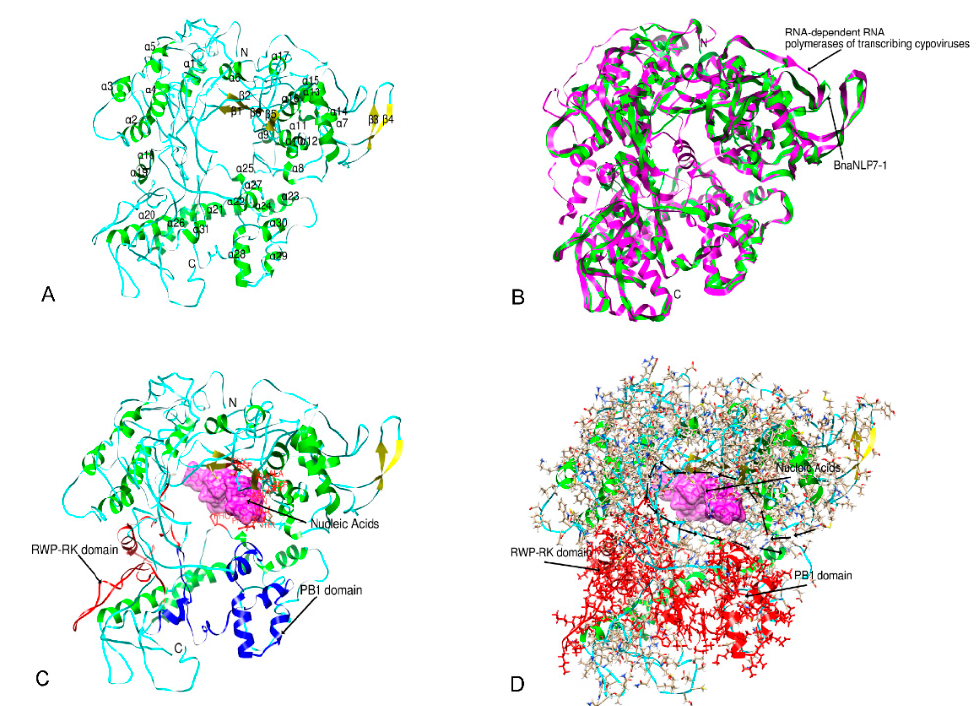
Figure 5. Predicted 3D structures of BnaNLP7-1 protein. The models were obtained using I-TASSER. tRNA-dependent RNA polymerases of transcribing cypoviruses (PDB ID: 3JA4) were used as the template for 3D structure predication. ( A ) 3D structure of BnaNLP7-1 protein; ( B ) template model of 3JA4 and 3D structure of BnaNLP7-1 protein; ( C , D ) binding between the BnaNLP7-1 dock and its nucleic acid substrate (PBD: 2r7rA); ( C ) the conserved PWP-PK domain and PB1 motifs are shown on the 3D structure in red and blue, respectively. The surface of the nucleic acid substrate is shown in purple. ( D ) The conserved PWP-PK domain and PB1 motifs are shown in red on the 3D structure. α -helices, β -strands, and random coils are indicated in green, yellow, and navy blue, respectively. All images were generated using Chimera 1.2.